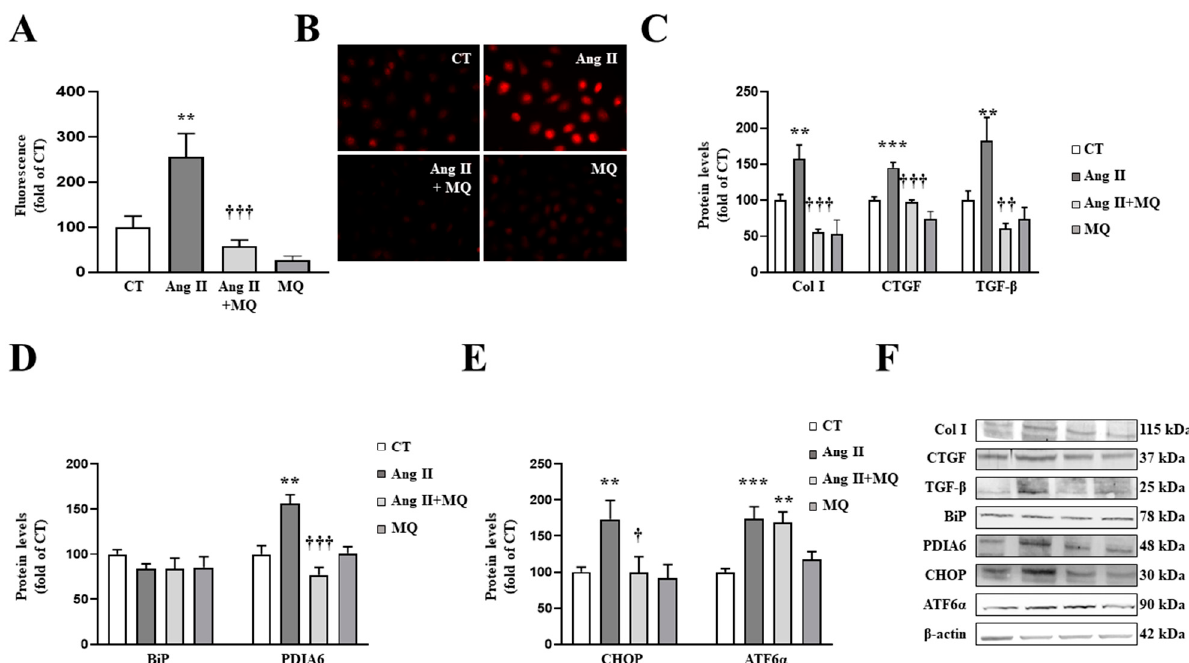
Figure 3. Mitochondrial oxidative stress mediates the prooxidant, profibrotic and the endoplasmic reticulum stress activation induced by angiotensin II (Ang II) in cardiac fibroblasts. ( A , B ) Effect of the mitochondrial antioxidant MitoQ (MQ; 5 nM) on superoxide anion production. Quantification of cells labelled with the oxidative dye dihydroethidium ( A ) and representative microphotographs (magnification 40×) ( B ). Protein levels of ( C ) collagen type I (Col I), connective tissue growth factor (CTGF) and transforming growth factor-beta (TGF- β ); ( D ) immunoglobulin binding protein (BiP) and protein disulfide isomerase family A member 6 (PDIA6); ( E ) CCAAT-enhancer-binding protein homologous protein (CHOP) and activating transcription factor 6-alpha (ATF6 α ) in cardiac fibroblasts treated with Ang II (10 − 6 M) for 24 h in the presence or in the absence of MQ. ( F ) Representative blots for protein expressions. Bars graphs represent the mean ± SEM of MS four to six assays normalized for β -actin. ** p < 0.01, *** p < 0.001 vs. control cells. † p < 0.05, †† p < 0.01, ††† p < 0.001 vs. Ang II-treated cardiac fibroblasts.